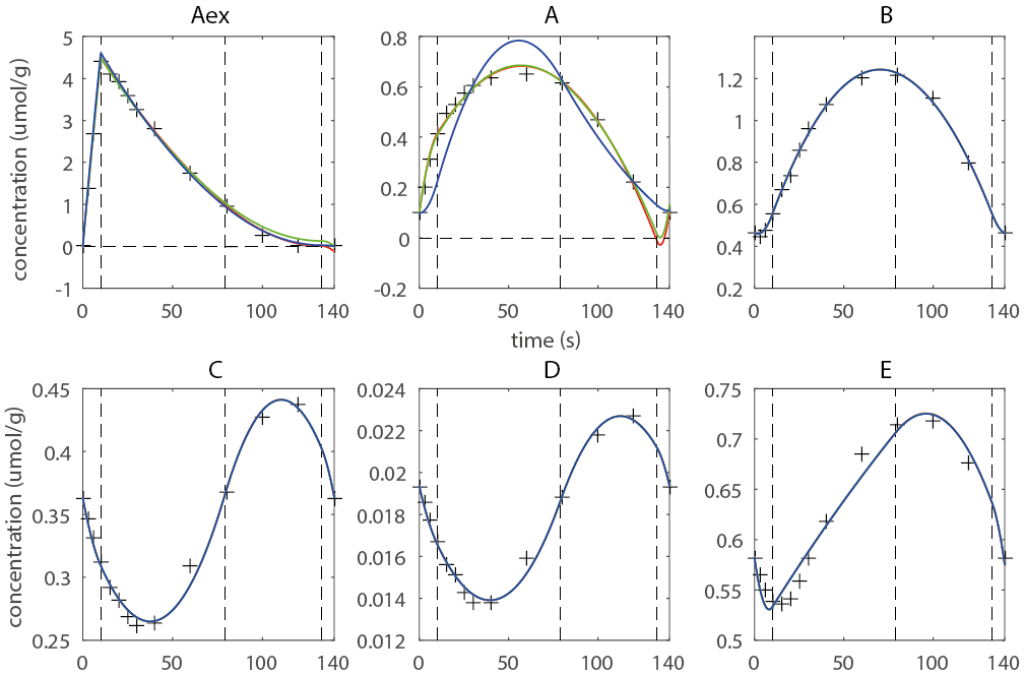
Figure 3. Estimated concentration profile using three free breakpoints t = (0s 10s 79s 133s 140s) ( red ), non-negativity constraints ( green ) and shape constraints for metabolite A ( blue ), the corresponding R c are 4.06 ( red ) 4.60 ( green ) and 72.79 ( blue